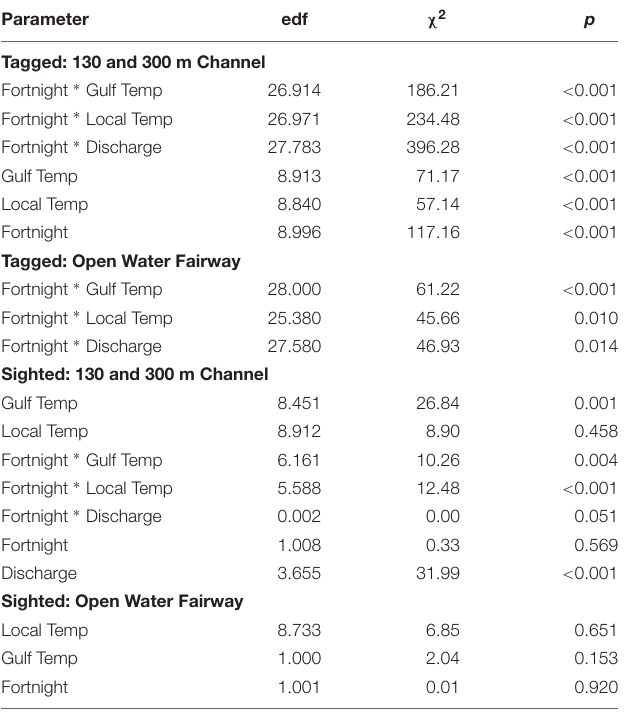
TABLE 5 | Best-fitting models for tagged and sighted manatees in the 130 and 300 m boat channels and fairways. Parameter edf χ 2 p